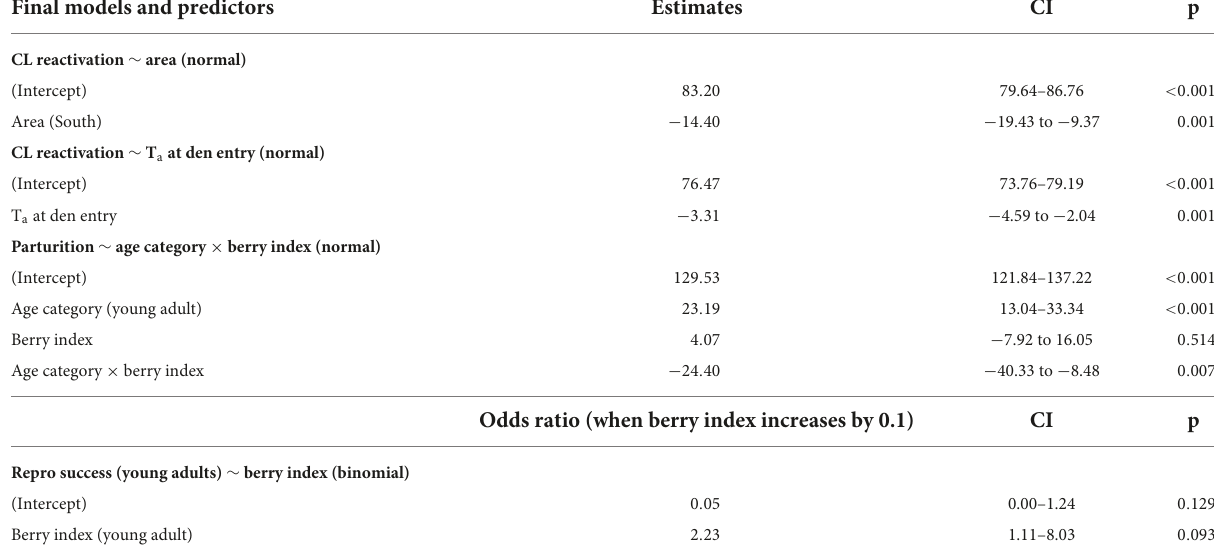
TABLE 3 Estimated parameters of the predictor variables included in the final models evaluating the factors influencing the timing of gestation and the reproductive success of Scandinavian brown bear females. Final models and predictors